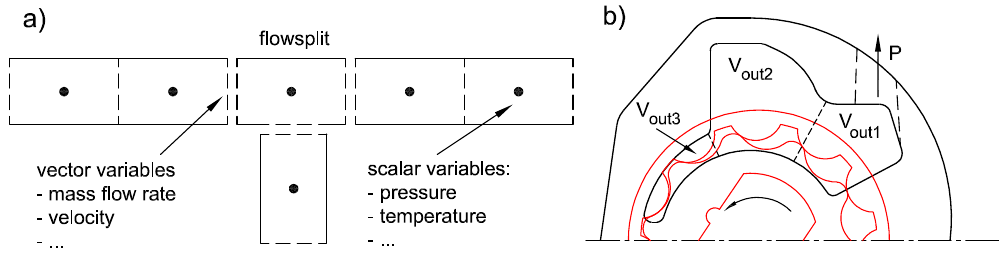
Figure 12. ( a ) Discretization of the flow domain in GT-SUITE; ( b ) example where the split of the delivery volume can be useful.